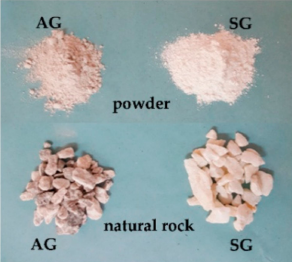
Figure 1. Samples of gypsum from Agadir (AG) and Safi (SG) (South-Western